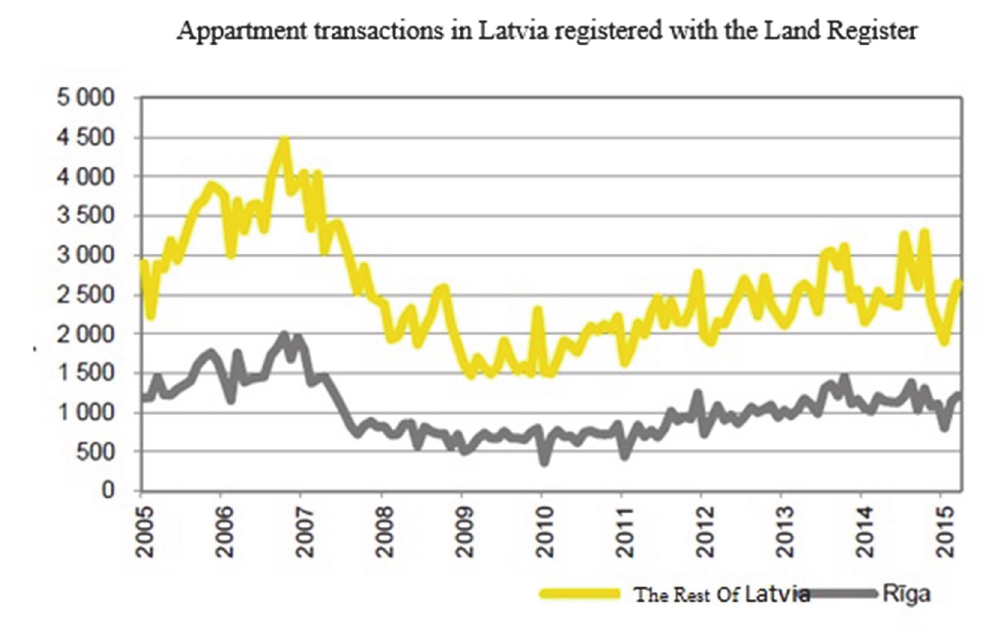
Fig. 1 . Number of real estate transactions in the housing sector (Latio,